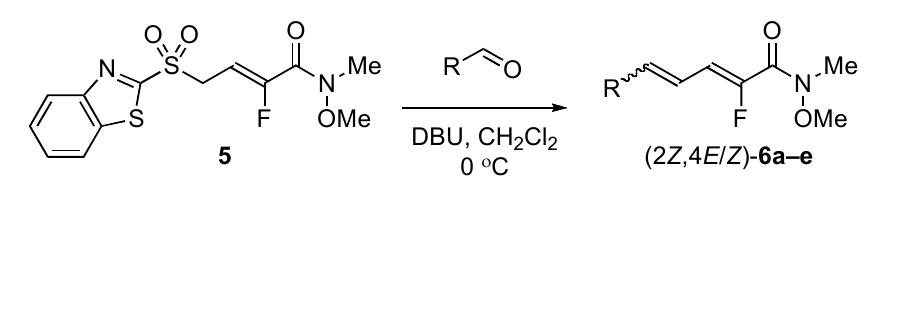
Table 4. Reactions of reagent 5 with aldehydes: yields, E / Z ratios, and 19 F-NMR